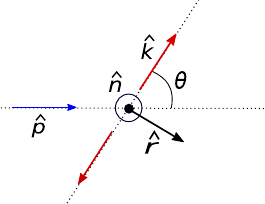
Fig. 1 The orthonormal basis for the spin projections. The blue arrow indicates the direction of one of the proton beams in the laboratory frame. The red arrows indicate top and anti-top directions in the tt center of momentum frame. The angle θ defines the angle between the beam and the outgoing top